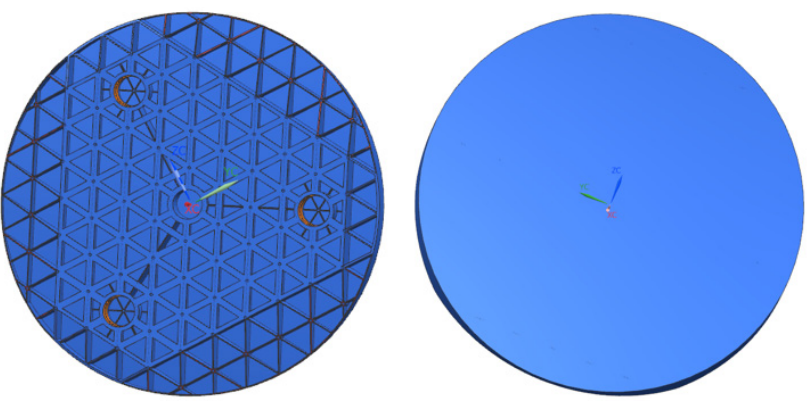
Figure 1. Mirror.